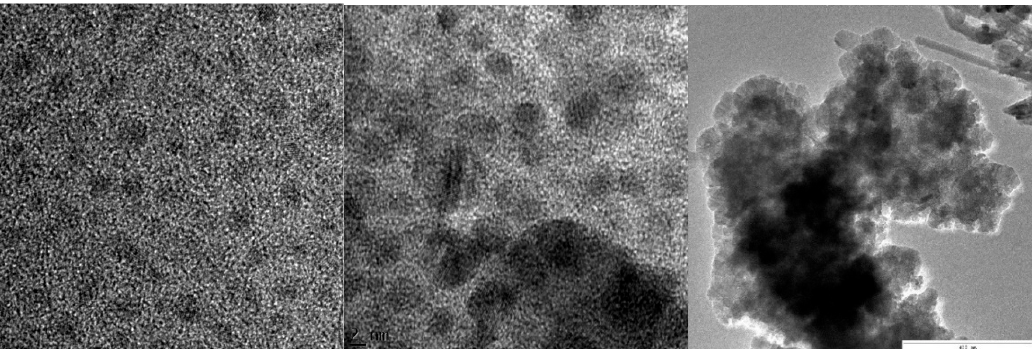
Figure 4. TEM micrograph of Ag:a-C thin films with varying fluence : sample A 2.5 × 10 16 ions/cm 2 (left), sample B 3.0 × 10 16 ions/cm 2 (center) and sample C 3.4 × 10 16 ions/cm 2 (right).